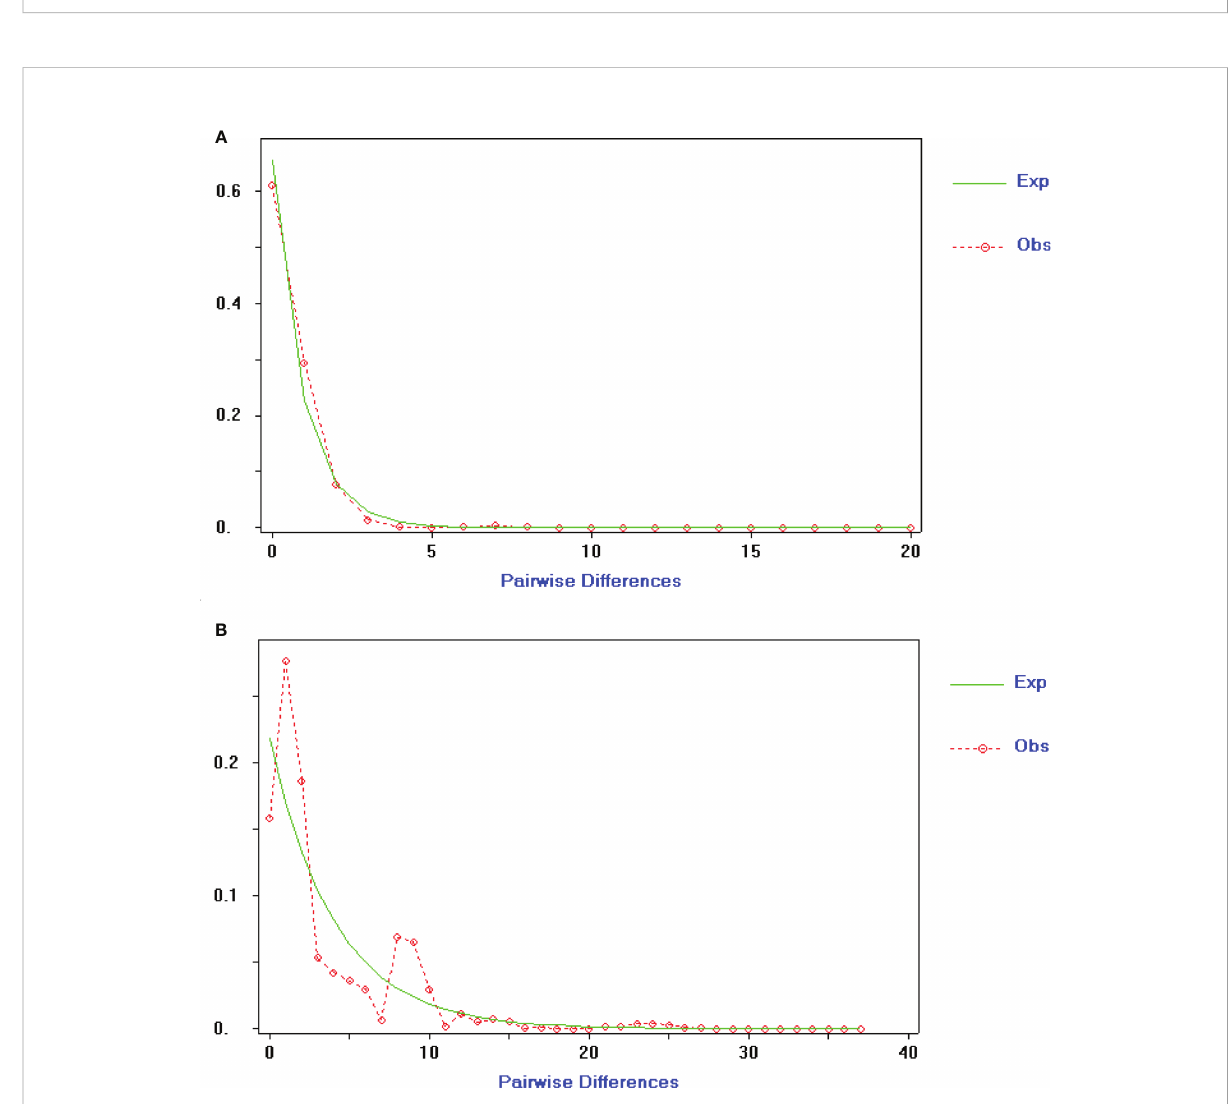
FIGURE 5 Mismatch-distribution analysis of cpDNA (A) and nrDNA (B) haplotypes for Ch. utilis